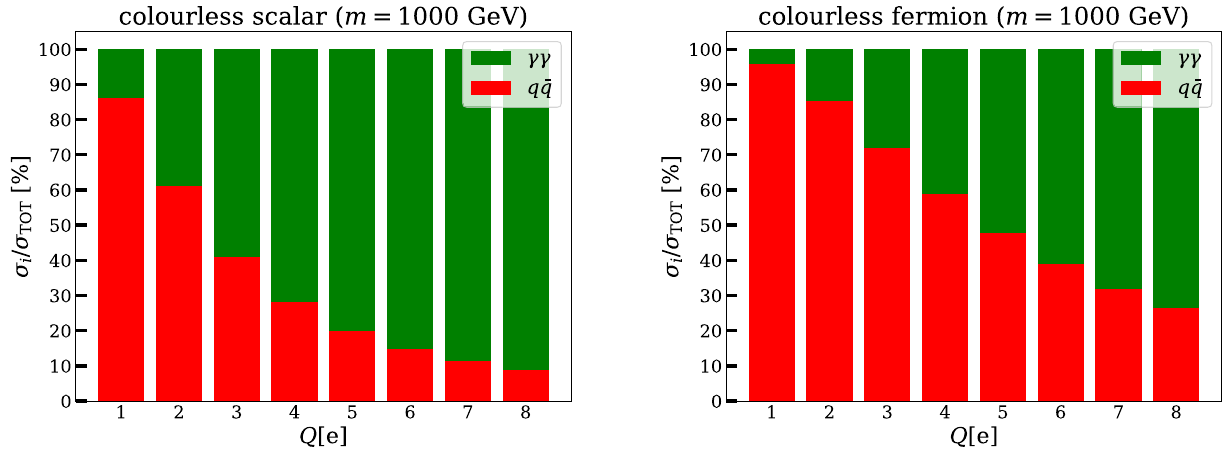
Fig. 3 Contributions of the q ¯ q (red) and γγ (green) initial states to the production rate for the colourless scalars (left) and fermions (right) with m = 1